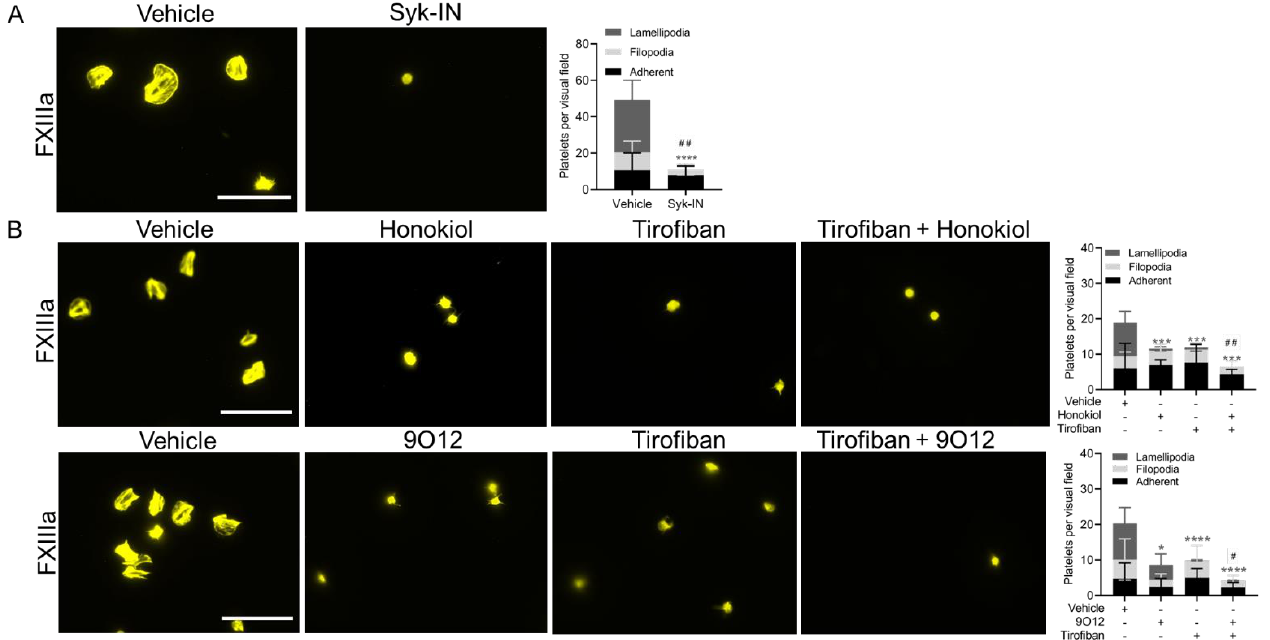
Figure 5. The role of Syk, integrin α IIb β 3 and GPVI in platelet spreading on FXIIIa. ( A ) Spreading on FXIIIa is Syk-dependent. Washed platelets (20 × 10 9 platelets/L) were treated with vehicle or Syk inhibitor PRT-060318 (20 µ M) and added to the FXIIIa-coated surface. Samples were fixed, permeabilized and stained with CF543-phalloidin. Spreading was assessed by fluorescence microscopy (bars, 20 µm). Two-way ANOVA, **** p < 0.0001, comparison between lamellipodia, mean ± SD, n = 4. Unpaired t -test, ## p < 0.01, comparison of platelets per visual field, mean ± SD, n = 4. ( B ) The role of GPVI in spreading on FXIIIa. Washed platelets (20 × 10 9 platelets/L) were treated with honokiol (50 µM) or 9O12 (50 µg/mL) ± tirofiban (1 µg/mL) as indicated and added to the FXIIIa-coated surface. Samples were fixed, permeabilized and stained with CF543-phalloidin. Spreading was assessed by fluorescence microscopy (bars, 20 µm). Two-way ANOVA, * p < 0.05, *** p < 0.001, **** p < 0.0001, comparison between lamellipodia, mean ± SD, n = 3 – 5. Unpaired t -test, # p < 0.05, ## p < 0.01, comparison of platelets per visual field, mean ± SD, n = 3 – 5.